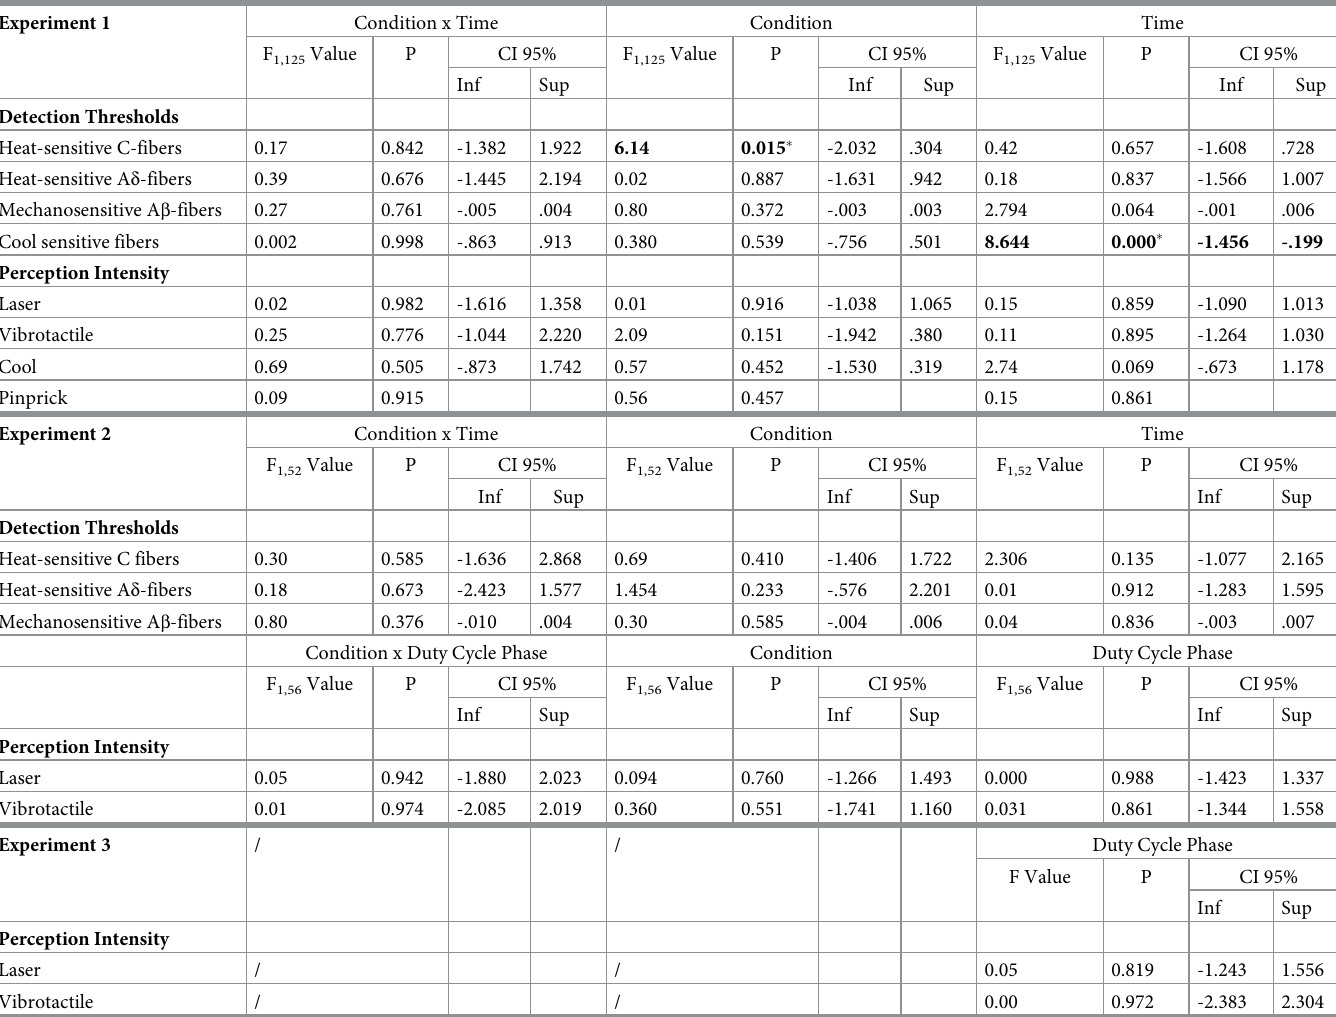
Table 2. Linear mixed models with within-subject factors ‘condition’ and ‘time’: Detection thresholds and perception intensity (Experiment 1–3). Experiment